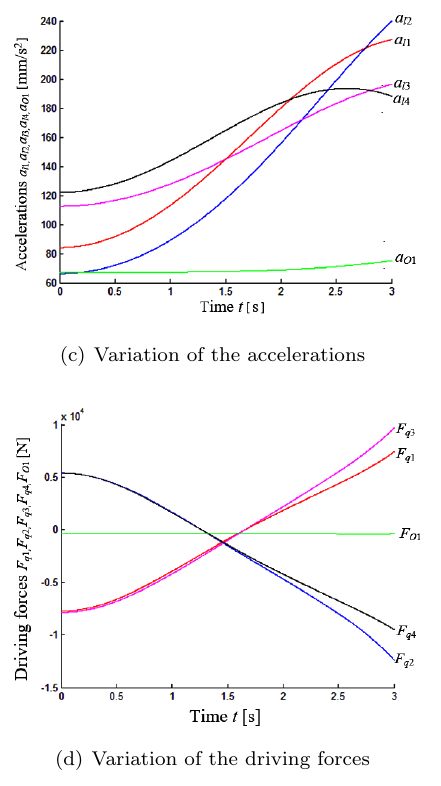
Figure 7: The kinematics and dynamics results of the GHMT obtained from developed model